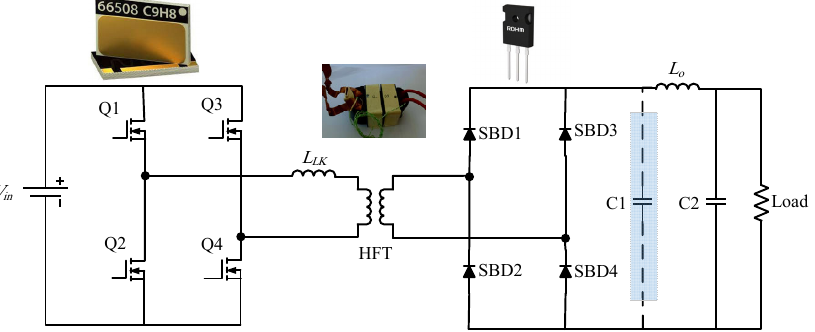
Figure 1. Topology of the GaN HEMT PSFB converter.